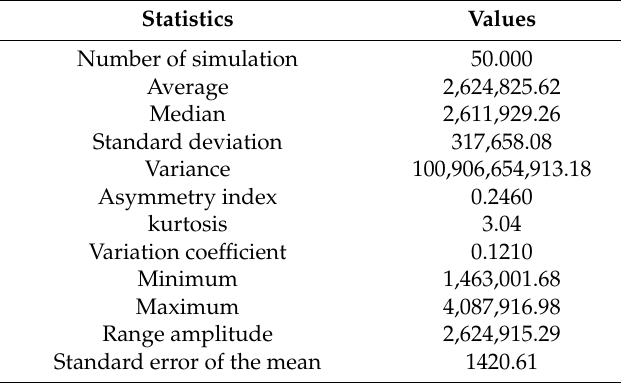
Figure 3. Output distribution obtained from the Monte Carlo simulation. Source: Crystal Ball software. In red, in the x-axis, there is the value of the former fire station according to NPL appraisal (1,040,000 Euro) and the evaluation of the former fire station in 2011 (3,500,000 Euro). Table 3. Summary of the statistics obtained by Monte Carlo analysis. Source: Crystal Ball